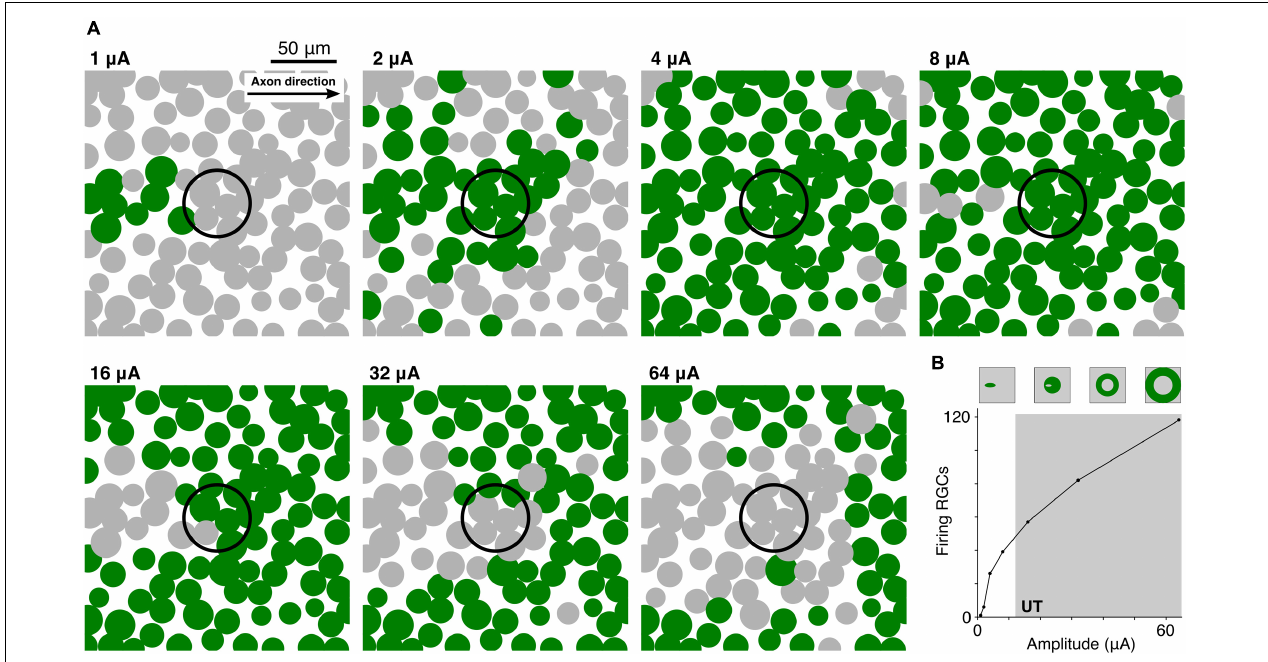
FIGURE 7 | High-amplitude stimulation results in distorted RGC activation patterns. (A) Top view of 100 RGC somas (filled circles) within a 200 × 200 µ m patch of the retina. Each RGC was rotated so that its axon pointed toward the right. RGCs were stimulated by a 50 µ m disk electrode (black unfilled circle) located 15 µ m from the epiretinal surface at amplitudes ranging from 1 to 64 µ A. For a given amplitude, green circles indicate cells which fired an action potential whereas gray RGCs did not respond. (B) 200 RGCs were stimulated within a region of interest 1 × 1 mm in size. The number of RGCs that fired an action potential is plotted versus the stimulus amplitude. Schematics on top indicate the transition of the activation pattern with increasing